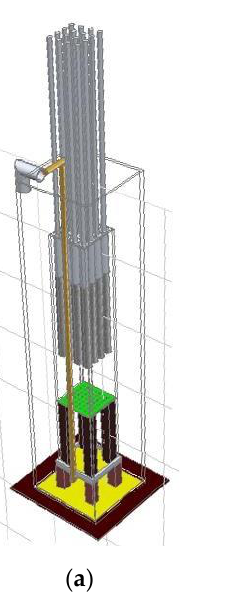
Figure 1. Sketch of experiment test section ( a ) and its vertical cross-section ( b ).